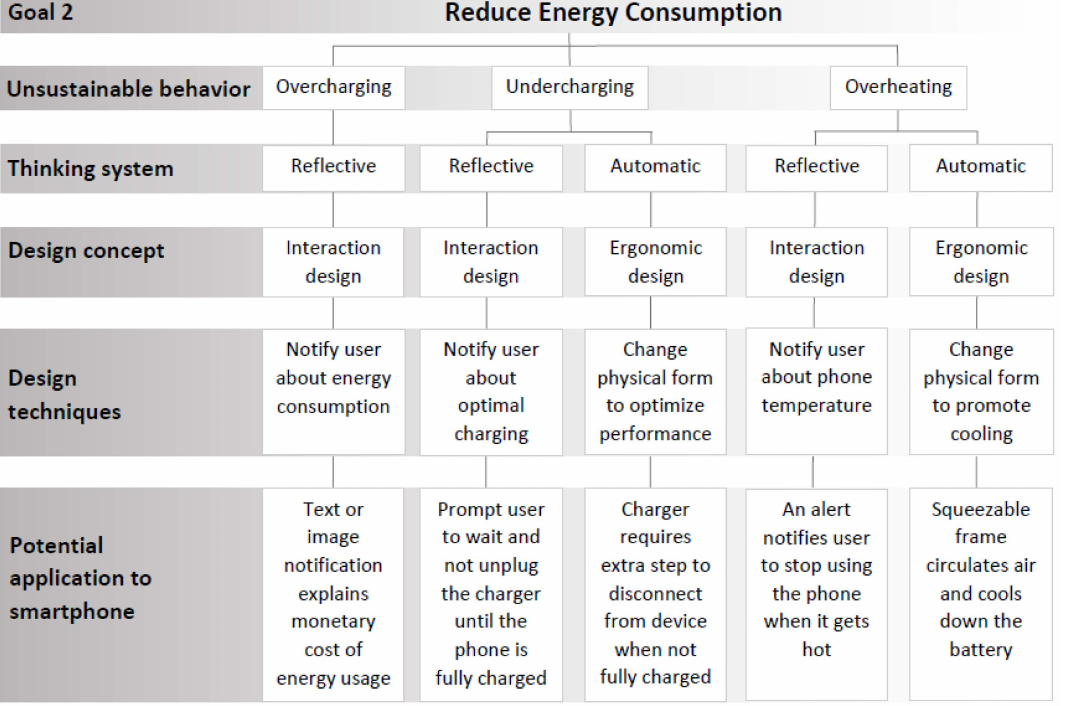
Figure 4. SBD Framework applied to meet Goal 2, “Reducing Energy Consumption”: examples of how notifications or changes in the product form can result in lower energy consumption and extended product